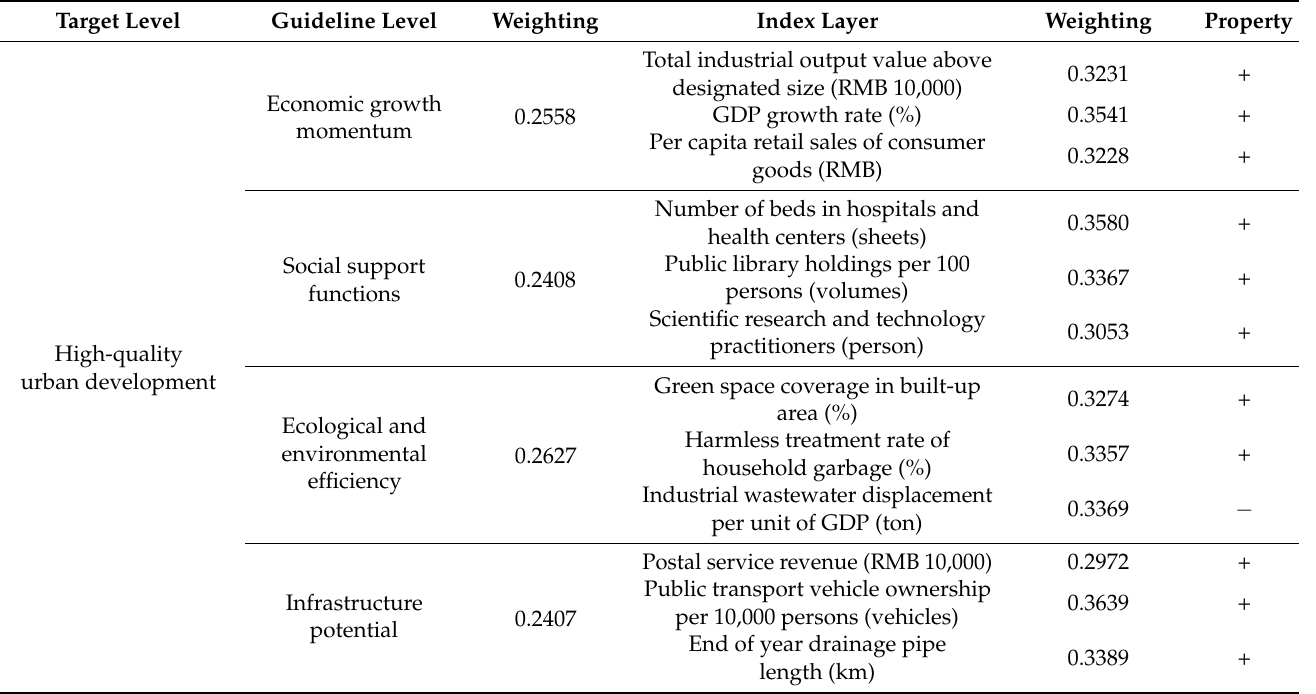
Table 1. High-quality urban development evaluation index